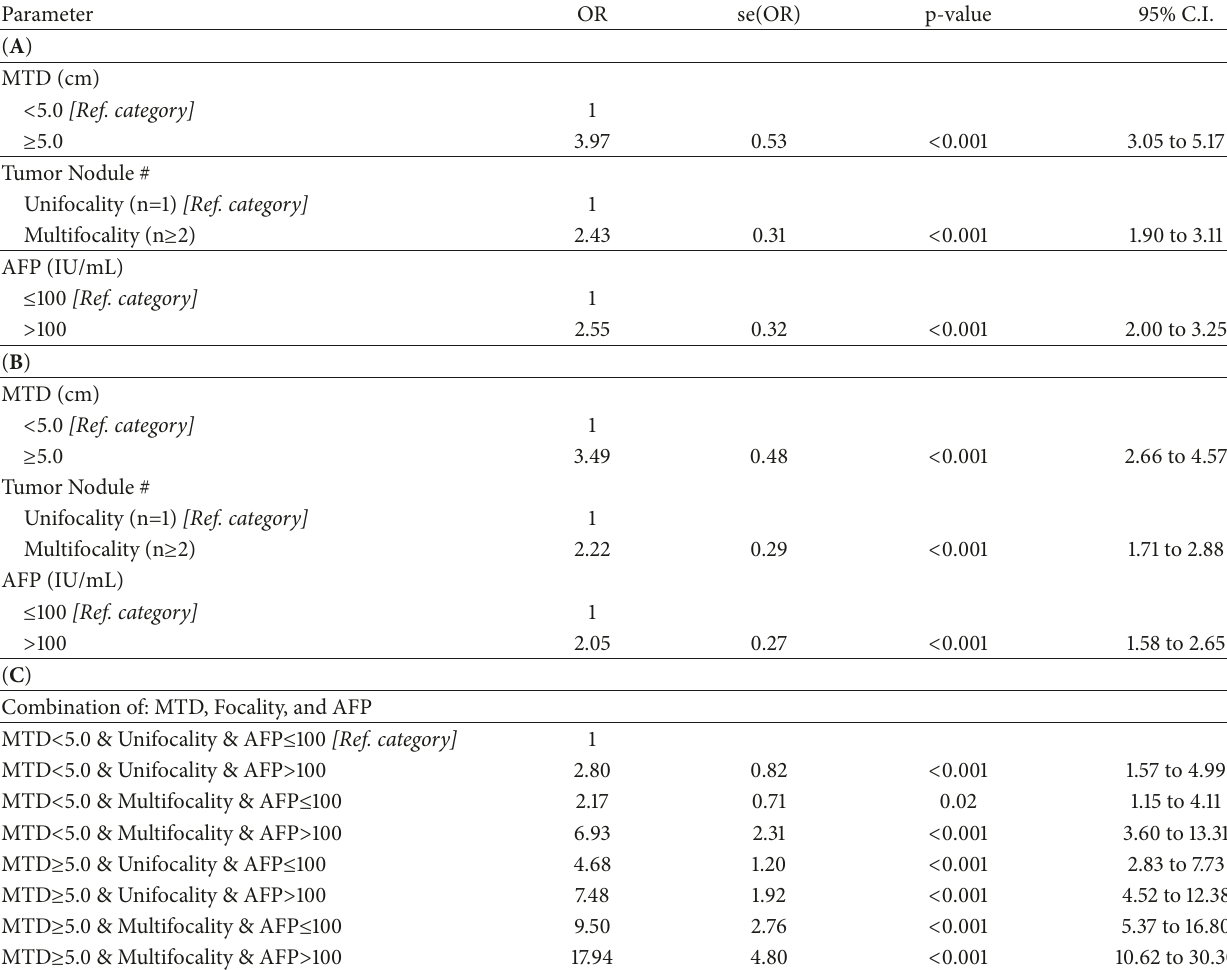
Table 3: Logistic regression model of PVT ( No/Yes ), on single variables ( A ), all as categories. Final multiple logistic regression model in stepwise method of PVT ( No/Yes ), on all variables as categories, included together in the model ( B ). Combination of MTD ( < 5.0/ ≥